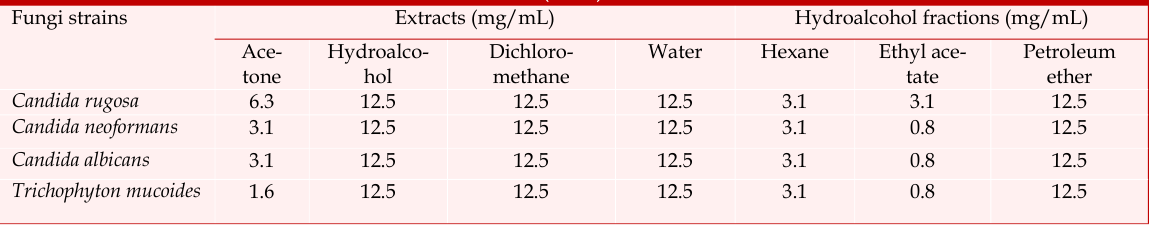
Antifungal activity of Dianthus basuticus extracts and fractions showing minimal inhibitory concentrations